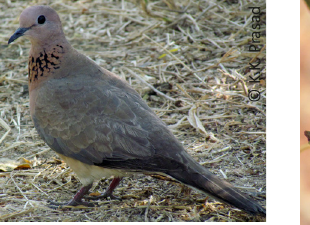
Image 34. Little Brown Dove Streptopelia senegalensis Image 35. Spotted Dove Strep-